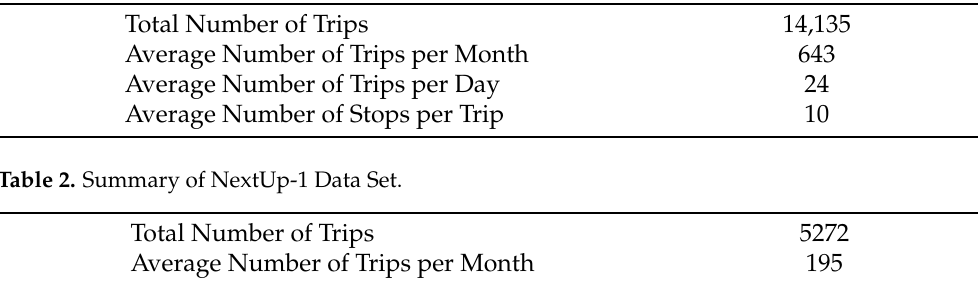
Table 1. Summary of NextUp-1 Data Set.